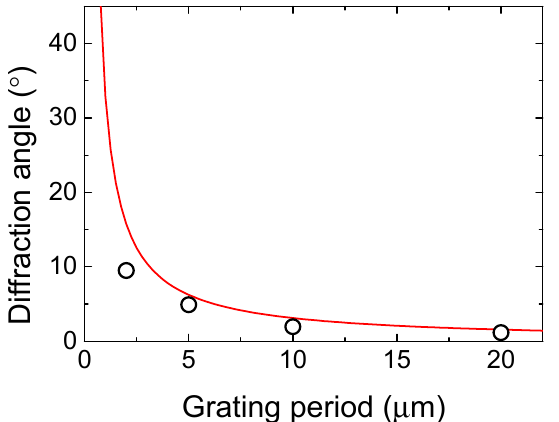
Figure 3. Diffraction angles (dots and line represent measured and calculated results, respectively) at first-order of the ULH cells as a function of grating period Λ . The thickness of LC cells was set as twice the pitch.